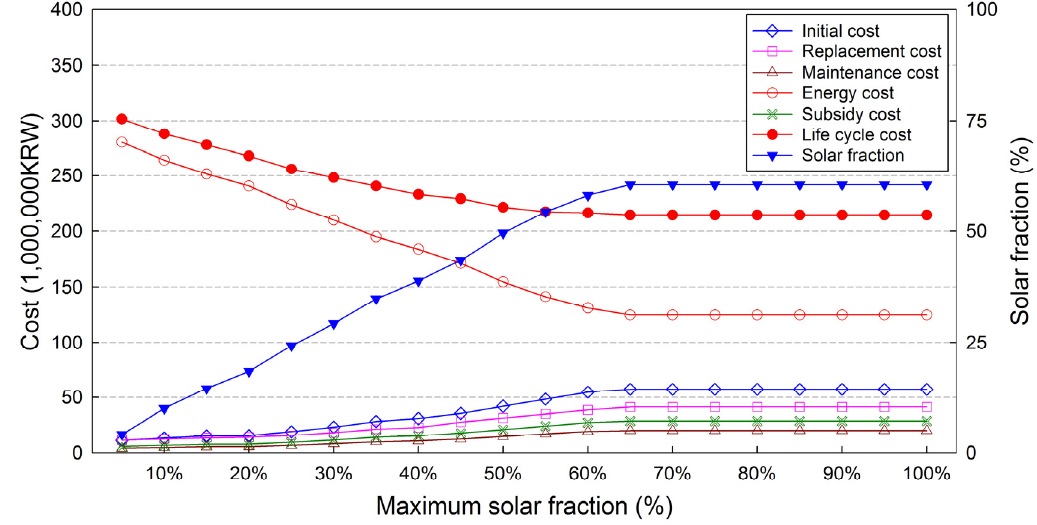
Figure 6. Variation of costs and solar fractions at the different maximum solar